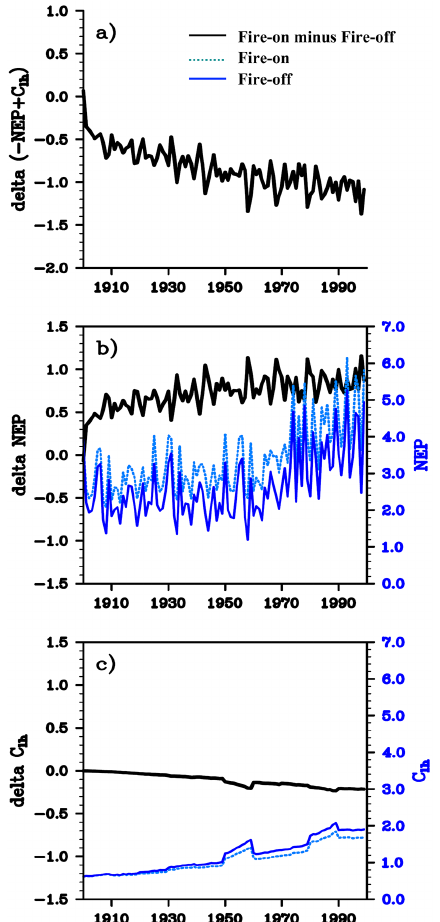
Fig. 5. (a) Fire indirect impact on NEE; (b) NEP and (c) C lh in fire- on and fire-off simulations and their differences. Unit is Pg Cyr − 1 .